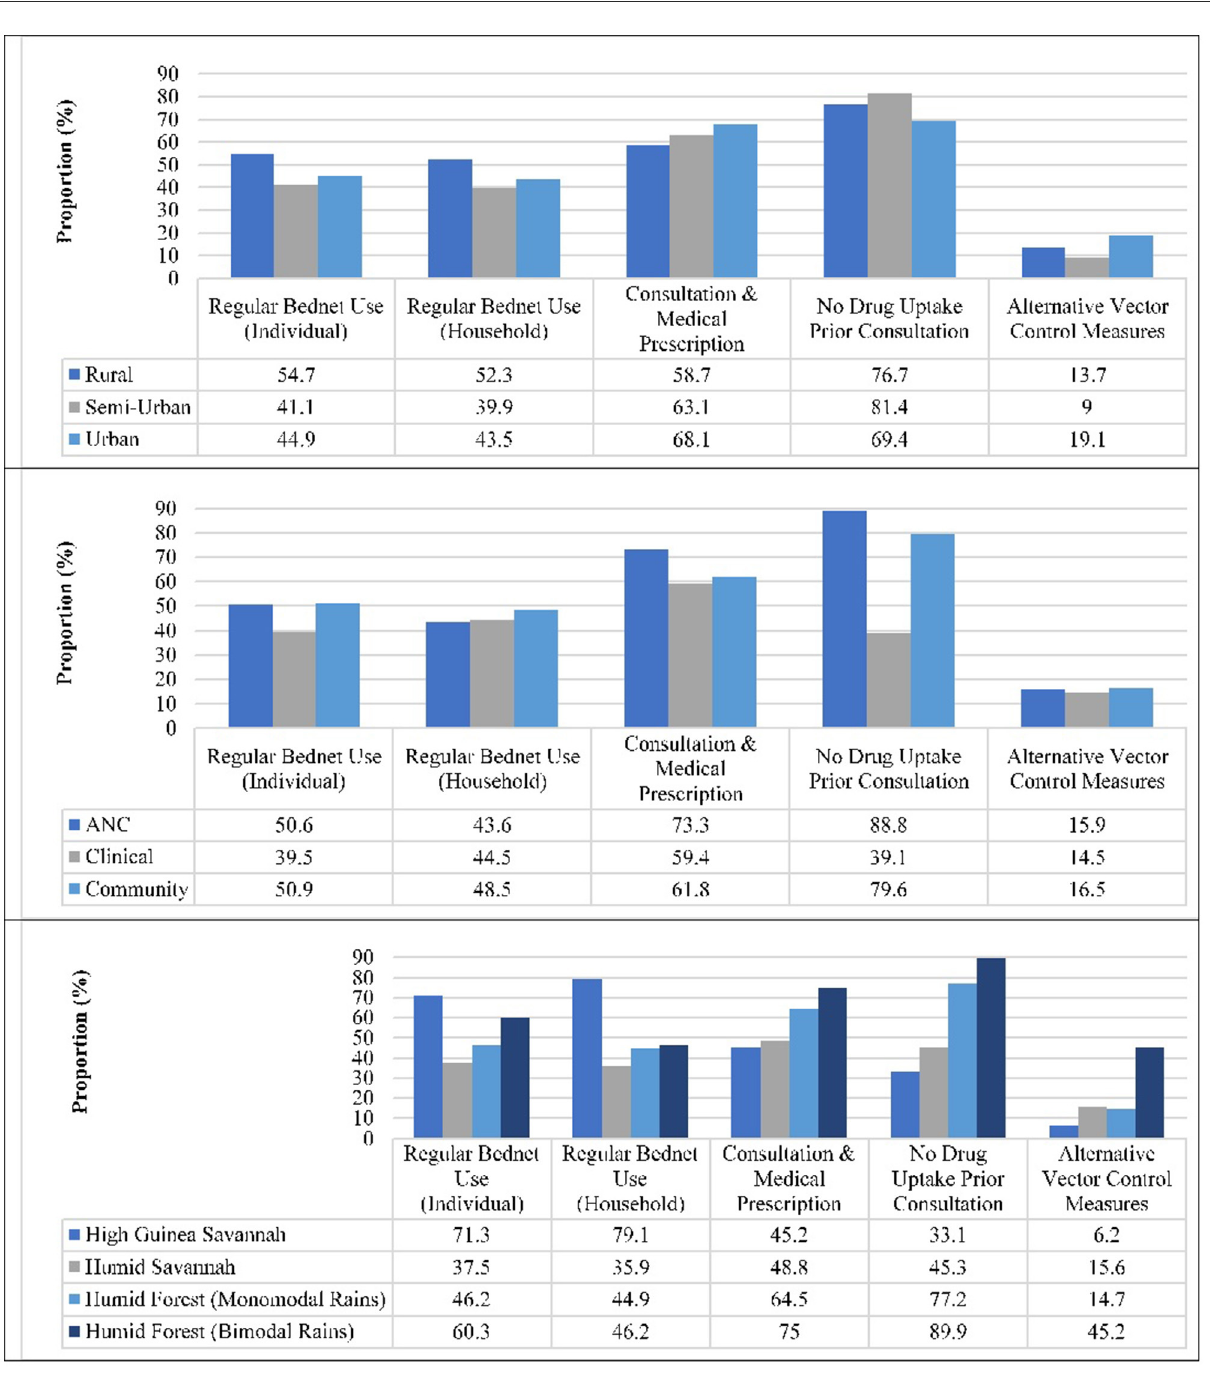
with fever at enrolment or history of fever (53.4%, p < 0.001) and anemic (52.1%, p < 0.001) compared to community surveys (32.6%), their afebrile (31.4%) and non-anemic (34.8%)